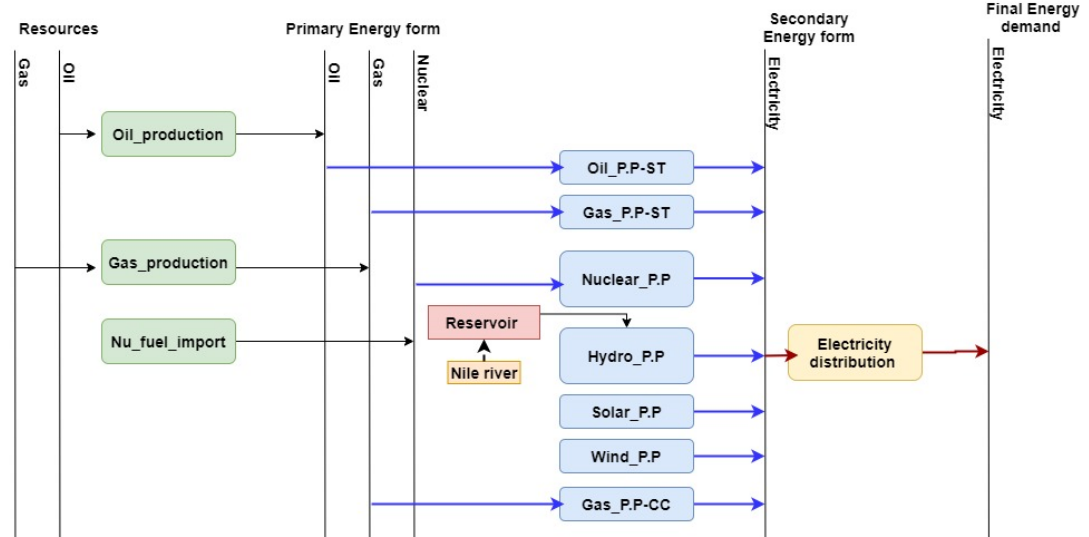
Figure 1. Energy chain in Egypt.